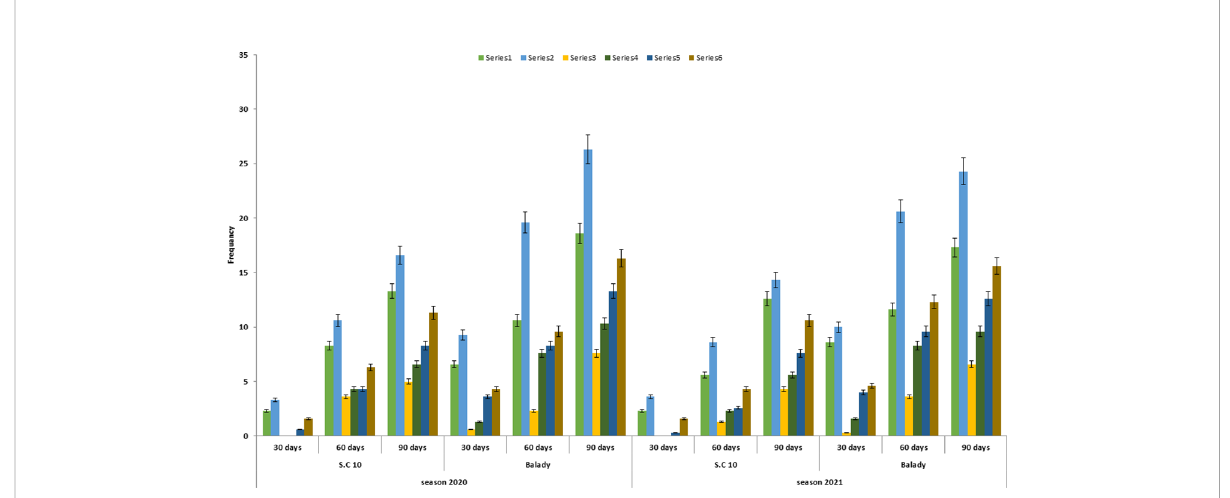
FIGURE 3 F. verticillioides frequency % from stalks under different tested treatments at different tested times after the sowing date during the 2020 and 2021 growing seasons.